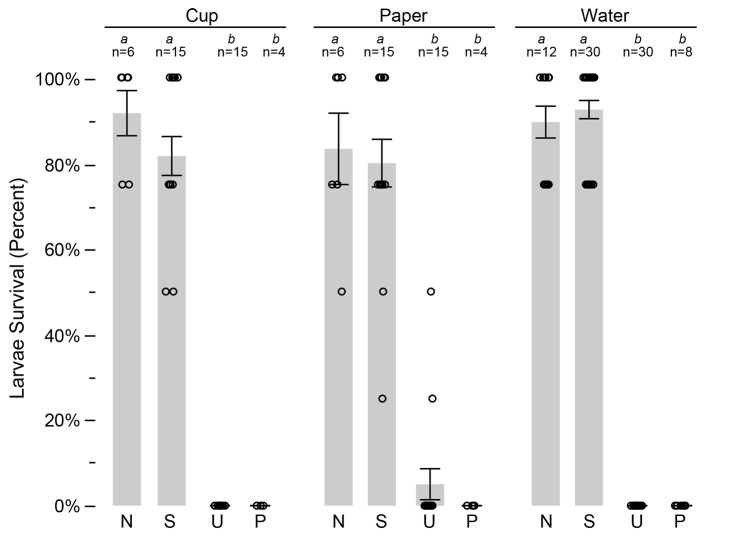
Oviposition cups removed from field cages were separate into three different components (i.e. cup, paper lining, and water), and each was examined for insecticidal activity using immature bioassays.For each component, screened (S) and unscreened (U) cups are compared, along with the negative (N) and positive (P) controls. Letters above the bars indicate significant differences (p < 0.01). The number of replicates is shown above each column. Bars show standard errors.